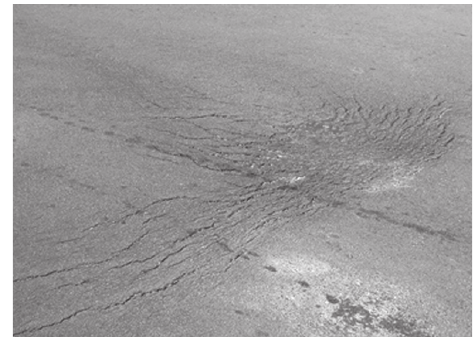
Fig. 1. A typical sample of slippage